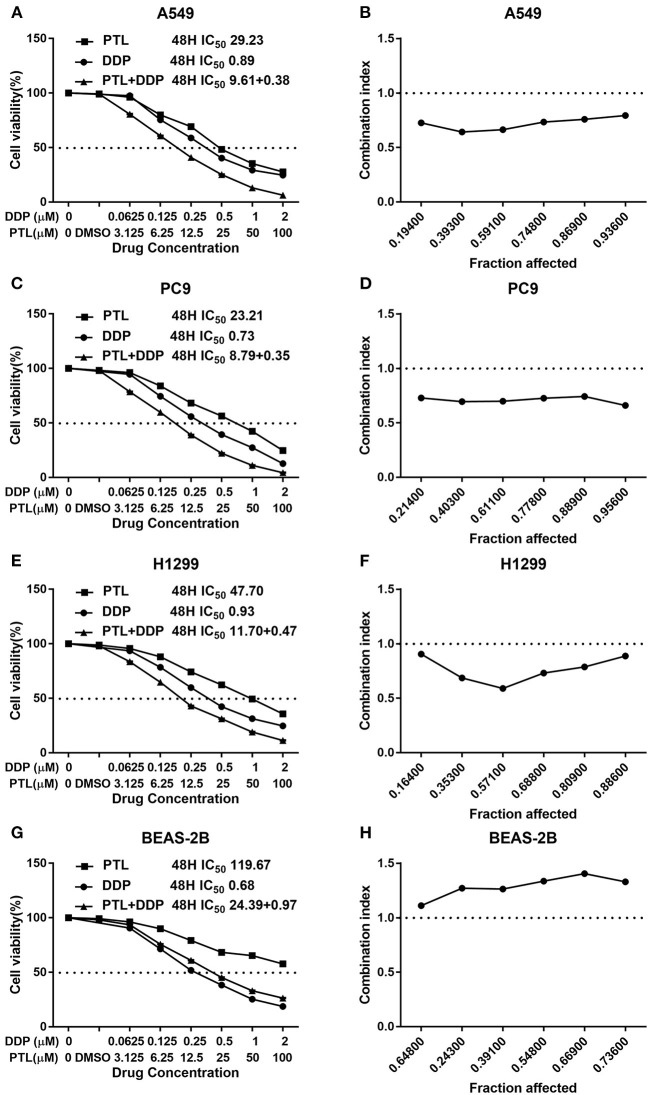
Proliferative inhibitory effect of PTL, DDP, and the combination treatment on NSCLC cells. Drug concentration–cell viability curves were generated as the viable cell percentage based on the cell viability assay (A,C,E,G). Synergistic effects between PTL and DDP are presented as Fa-CI plots (B,D,F,H). Data are from three repeated experiments with quadruplicate wells (mean ± SD).